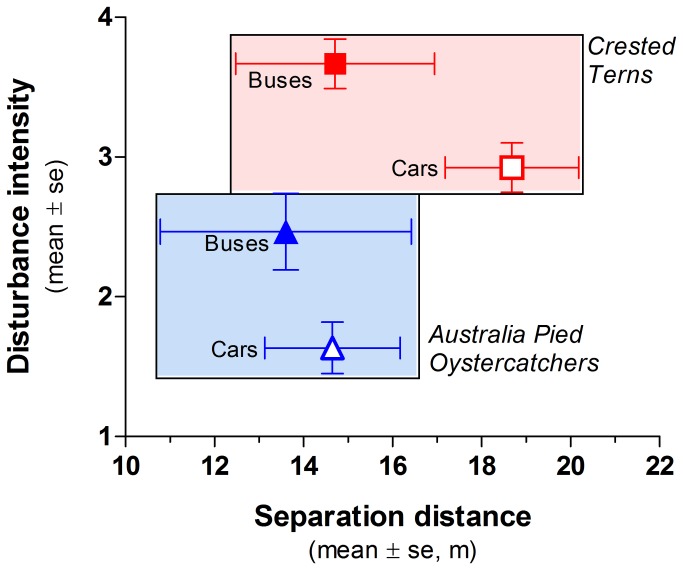
Comparison between buses and cars in terms of the intensity of disturbance-related behaviours shown by birds and the distances separating vehicles from birds for terns and oystercatchers.